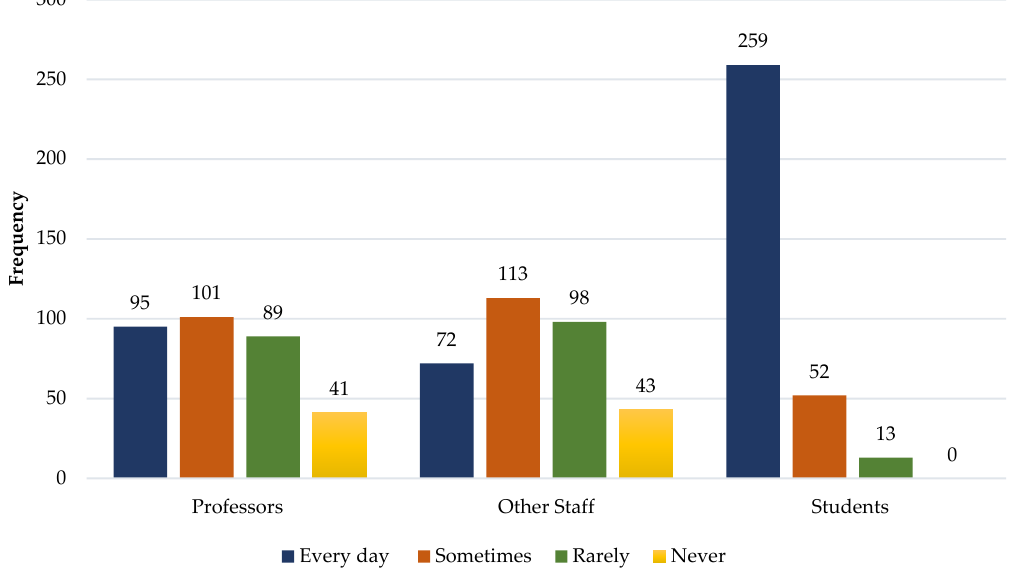
Figure 3. Frequency at which professors, other staff and students smoke at the entrance doors of university buildings.